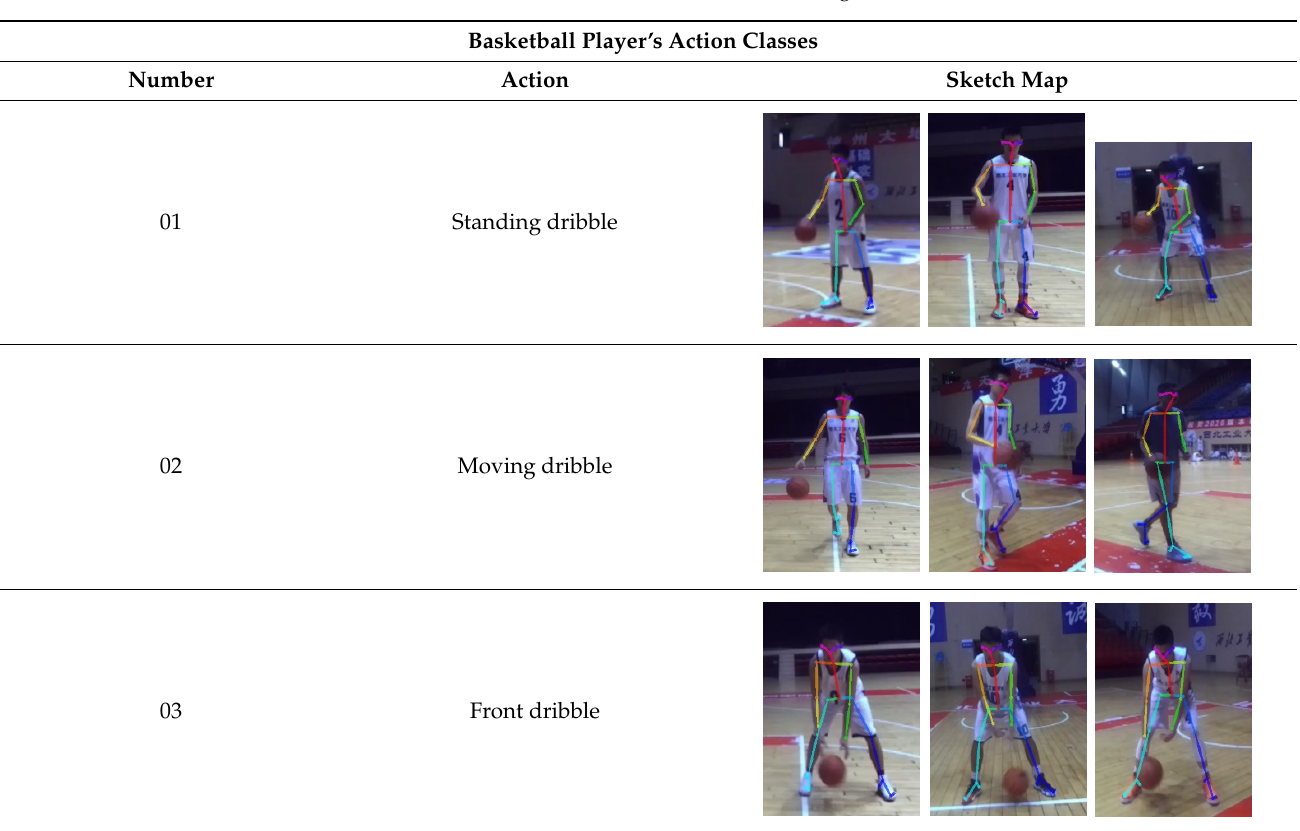
Figure 2. The definitions and a decomposition of all complex basketball movements. From top to bottom, it is the detailed action classification of ( a ) movement, ( b ) ball control, and ( c ) shots in basketball. Table 2. The list of all 12 basketball action categories.